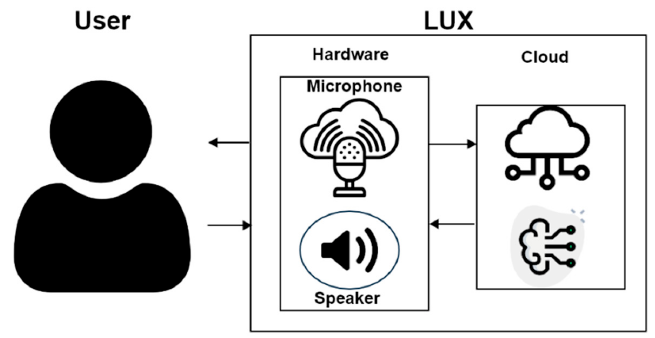
Figure 5. Interaction between LUX and the